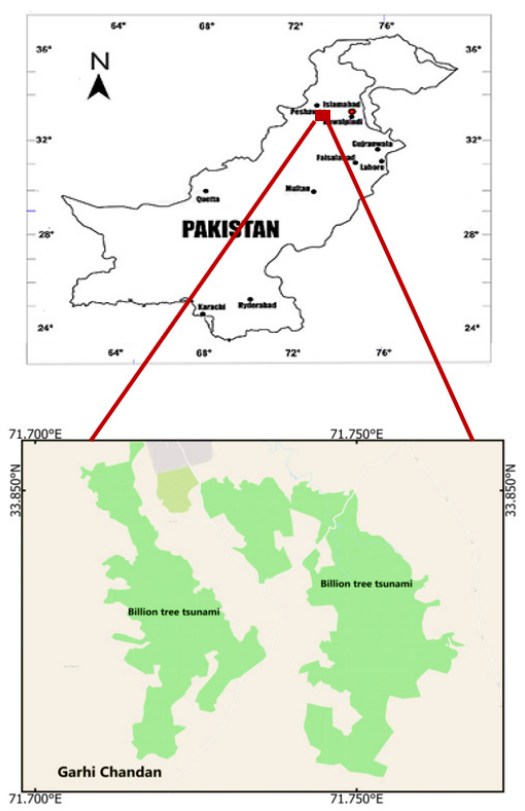
Figure 1. Geographic map of Pakistan and the study area encircled in red rectangle.